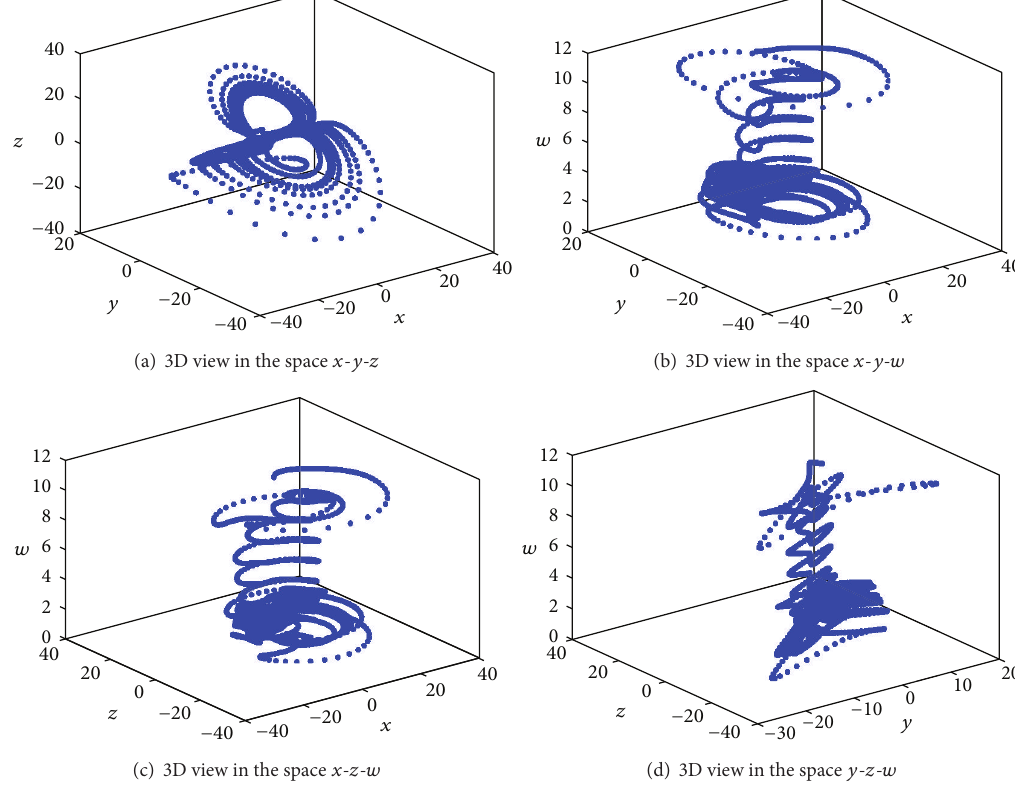
Figure 5: Chaotic